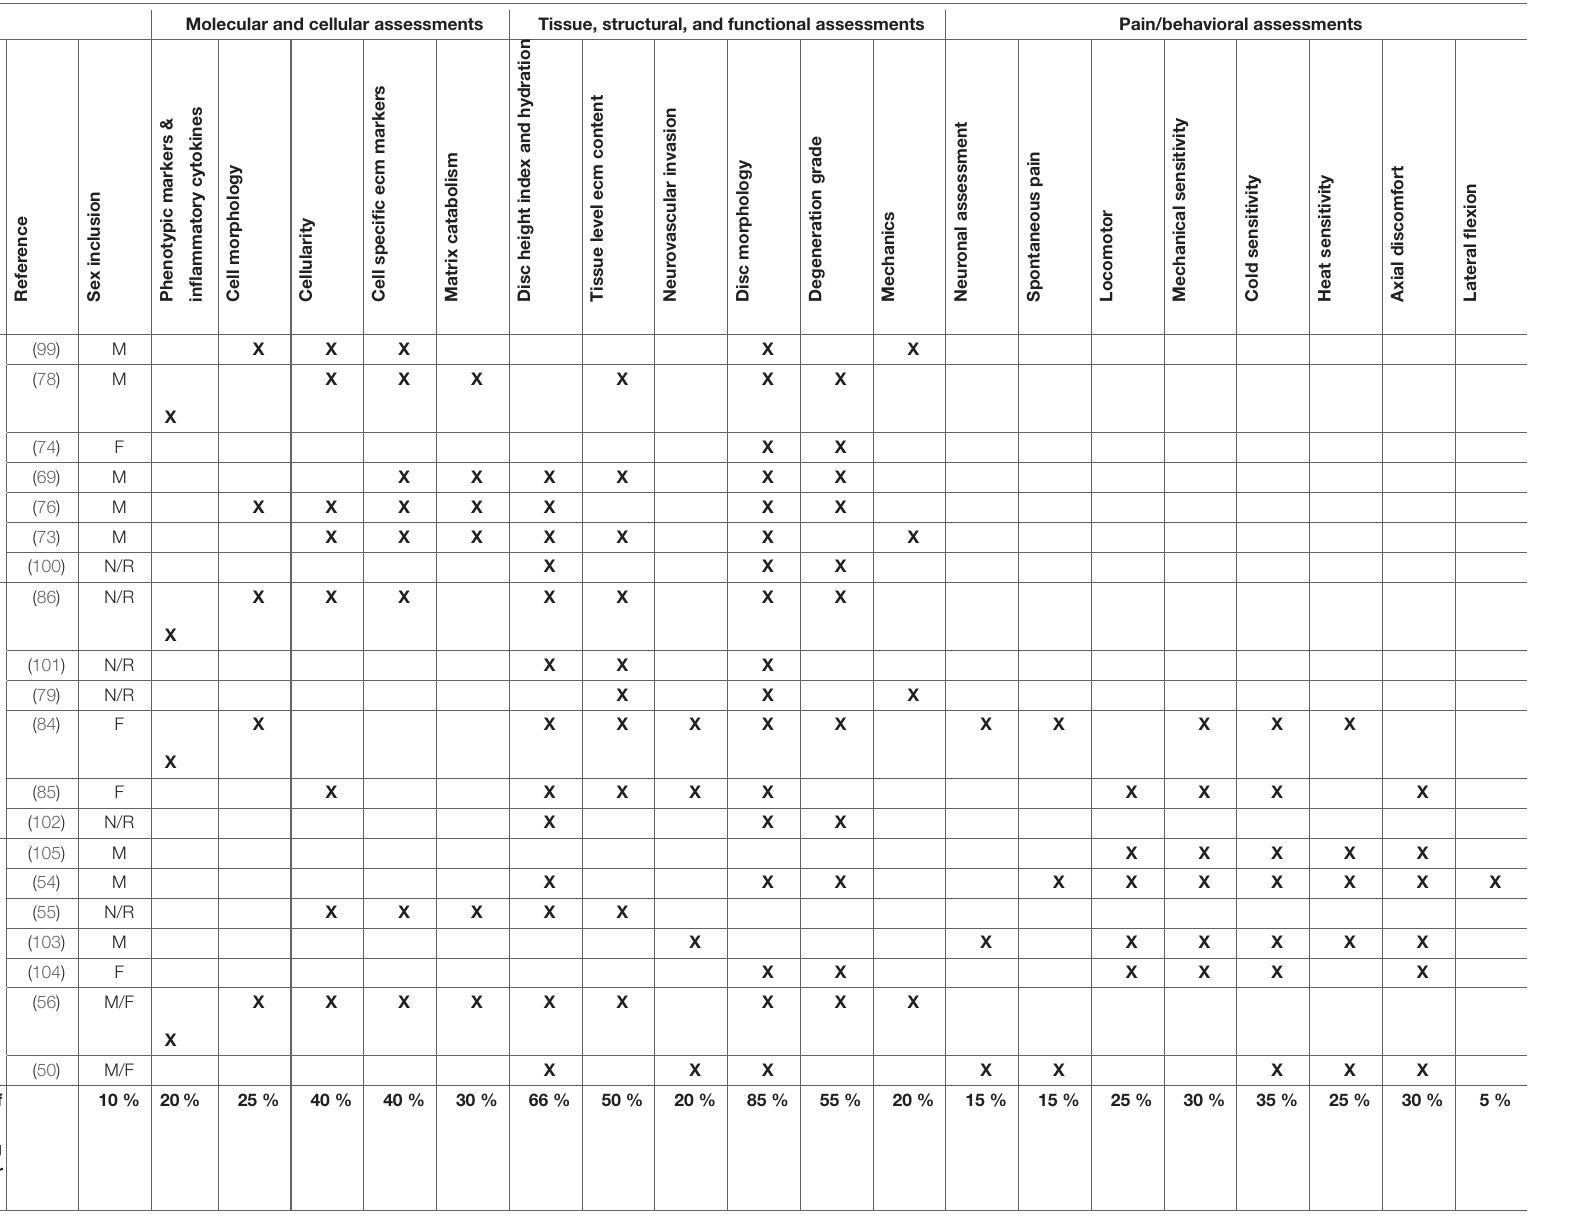
TABLE 4 | Summary of assessed parameters across mouse models of IVD